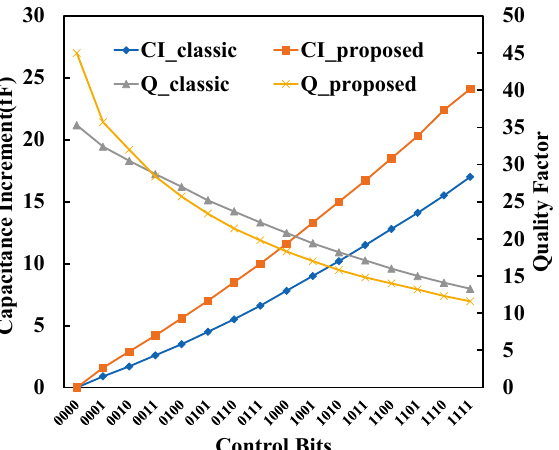
Figure 12. Diagrams of ( a ) the traditional DiCAD structure, and ( b ) the proposed DiCAD structure.